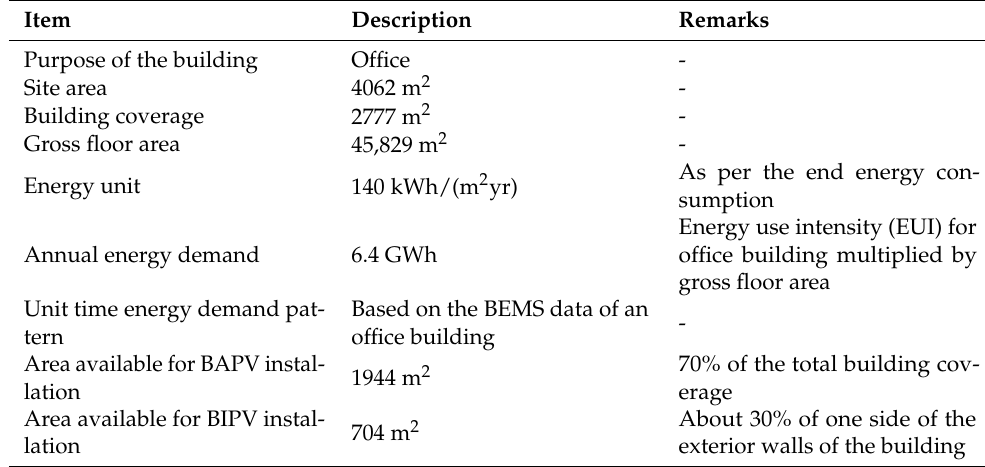
Table 6. The building setting information for the case